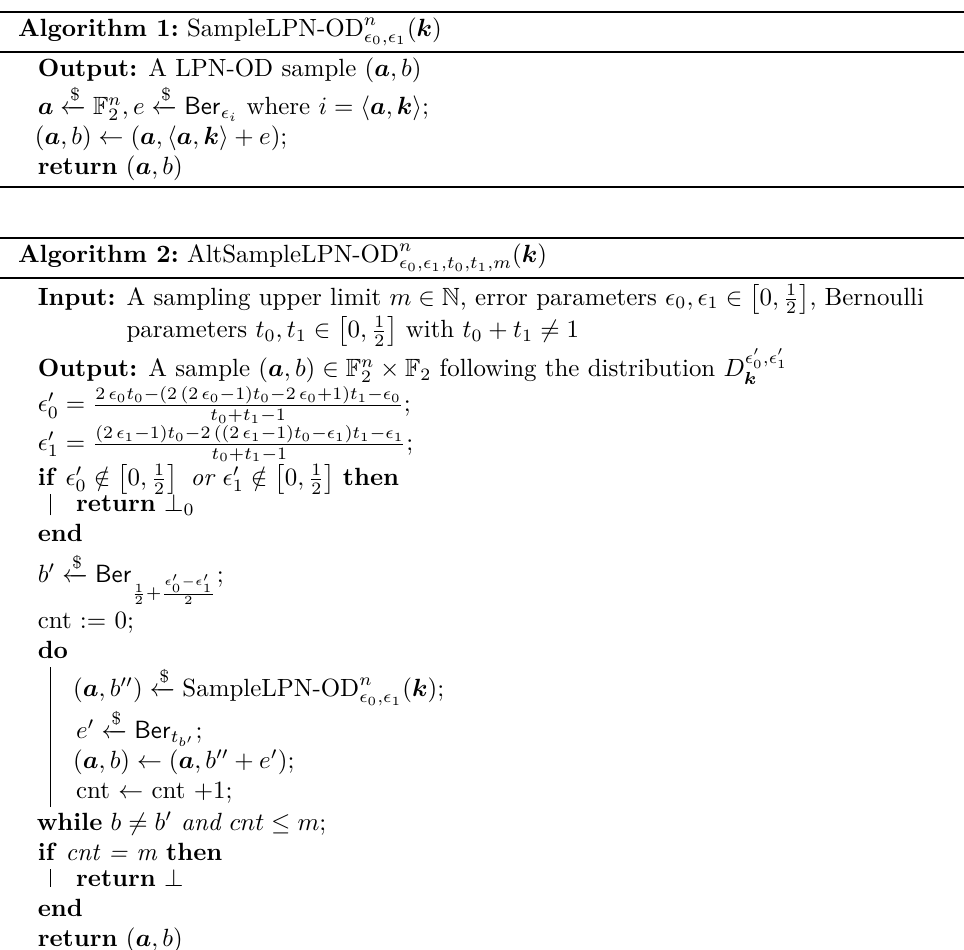
( k ) (cid:15) 0 ,(cid:15) 1